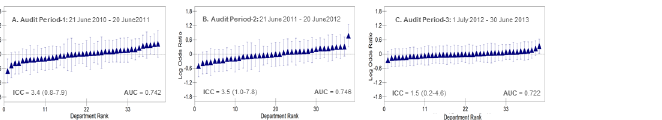
Fig 2. Ranking of 57 Danish departments for the three audit periods (A-C) accordingto their one-year mortality for incidentheart failure (21 June 2010–30June 2013) using the overall averageas reference. Valuesare logarithmodds ratios (i.e., shrunkenresiduals)with 95% confidenceintervals(vertical lines) adjustedfor age and gender(see model 2 in Table 3). The figure also indicates the values of the departments intra-class correlationcoefficients(ICC) for one-yearmortality and the AUC.